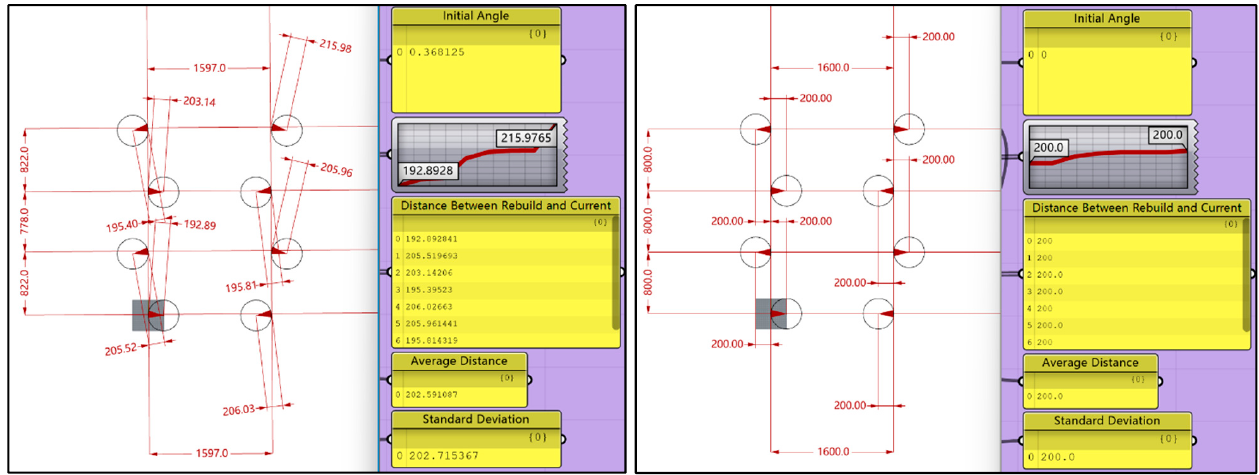
Figure 13. Verification of eight symmetric columns (the disordered axes on the left, the result axes on the right).